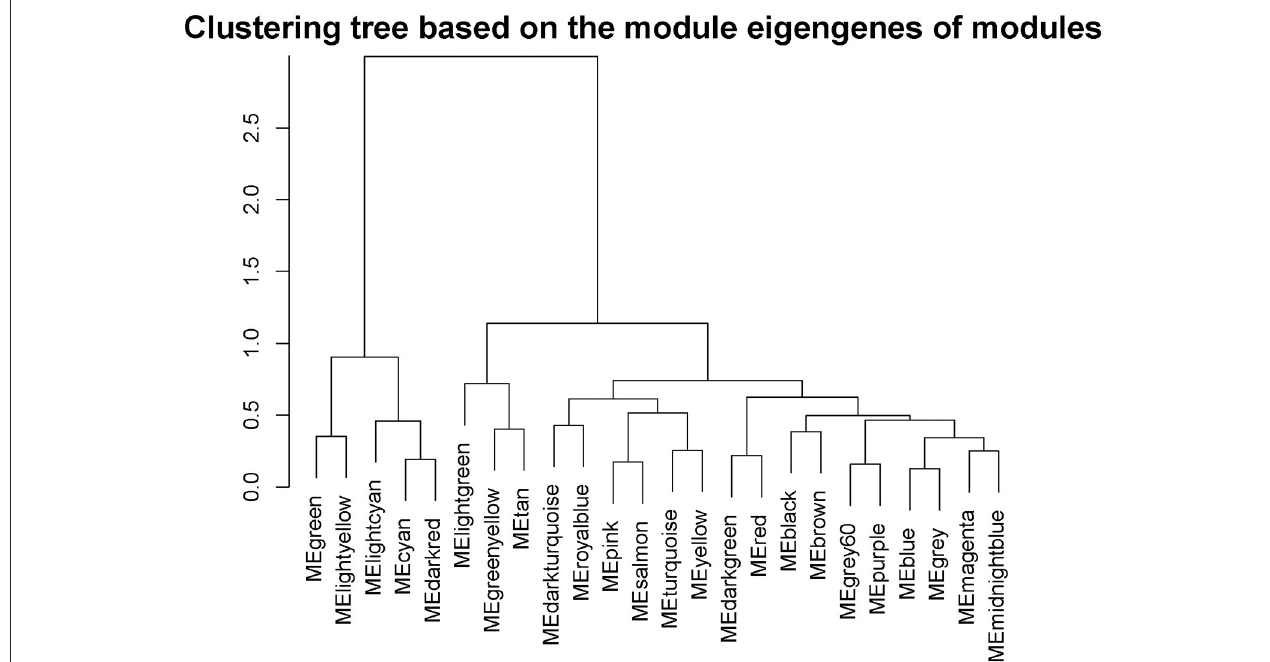
FIGURE 4 | Hierarchical clustering of module hub genes that summarize the modules yielded in the clustering